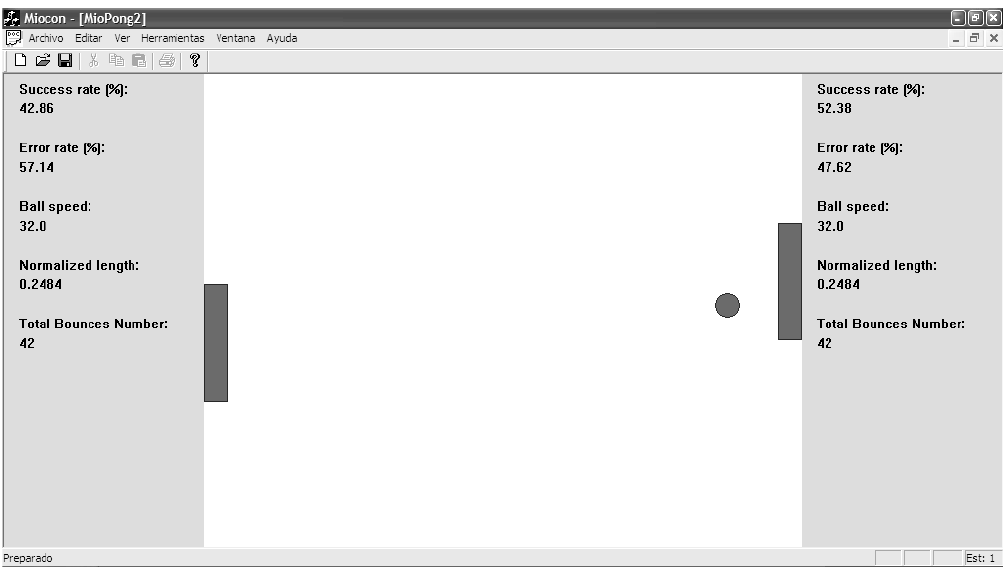
Figure 9. Appearance of the MyoPong game